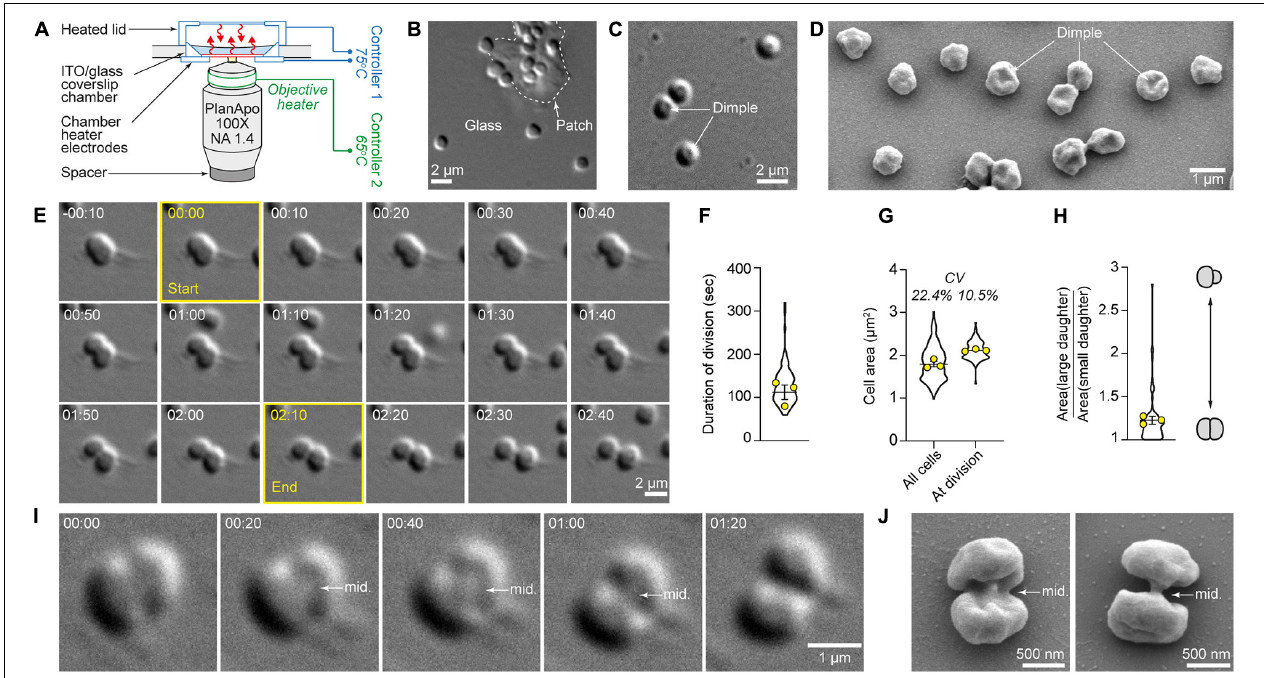
FIGURE 1 | High-temperature microscope system allows high-resolution quantitative live-cell imaging of cytokinesis in single S. acidocaldarius cells. (A) Bioptechs Delta T setup. (B) S. acidocaldarius cells adhered to the glass surface and a patch of solid media, imaged in DIC at 75 ◦ C. (C) Representative example of cells exhibiting a central dimple, imaged in DIC at 75 ◦ C. (D) Scanning electron micrograph of surface-adhered S. acidocaldarius . Some cells show a central dimple as shown in C . (E) Snapshots of a cell undergoing cytokinesis. The frames used to define the start and end points of the division event are outlined in yellow. (F) Quantification of the duration of division in 86 cells. (G) Quantification of cell area in 184 non-dividing cells and 86 cells just before division. The coefficients of variation are given (CV). (H) Ratio of the cell area of daughter cells at birth. Violin plots: all cells. Superimposed yellow circles: average values from each of three independent experiments. Bars represent the mean ± SEM of those three biological replicates. (I) Observation of the midbody (mid.) during cell division imaged in DIC at 75 ◦ C. (J) Scanning electron micrographs of dividing S. acidocaldarius cells showing early and late midbodies (mid.; left and right, respectively). Times are provided in